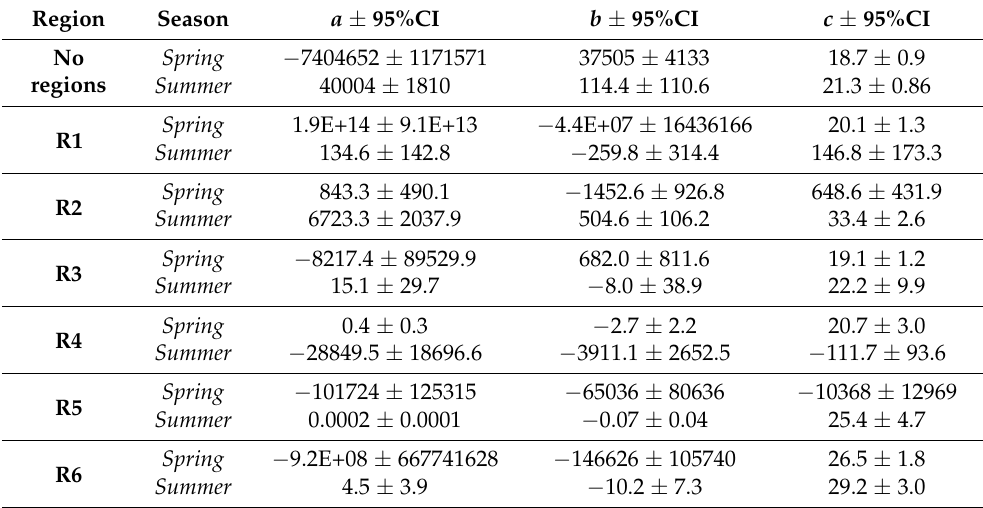
Table 8. The coefficients of the quadratic polynomial regression ( a , b and c , used in Equation (1)) to derive TN with the 95% confidence interval values